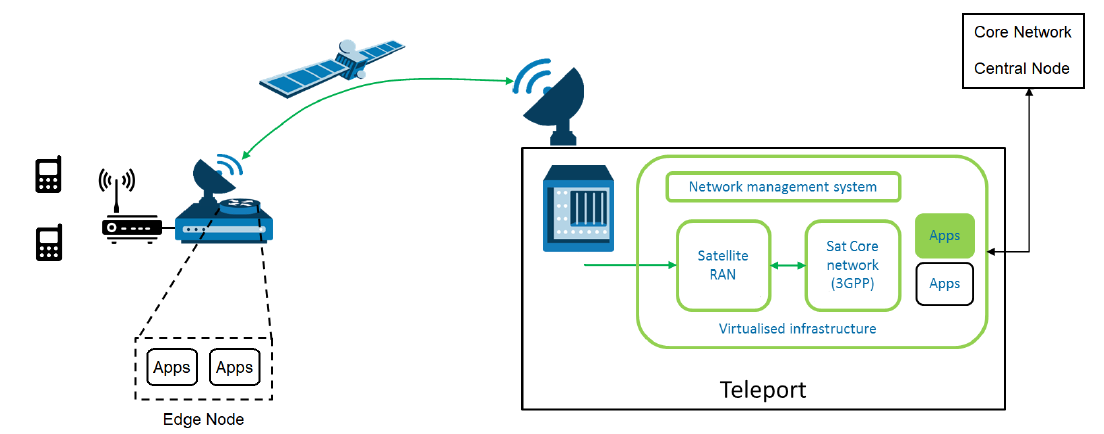
Figure 7. Satellite integration into 3GPP architecture (Setup